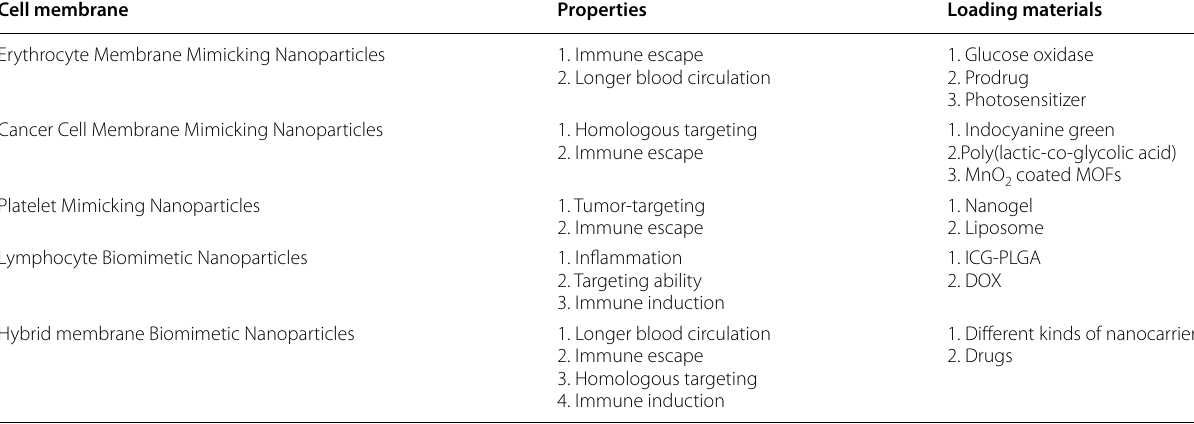
Table 1 Biomedical functional of various cell membrane Cell membrane